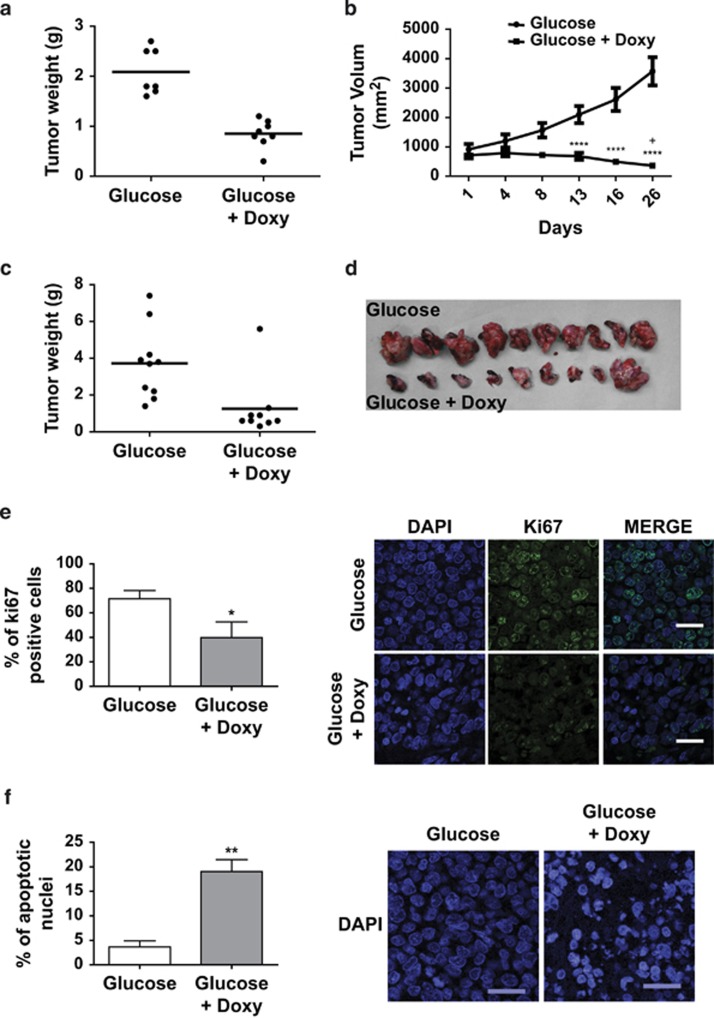
HDAC7 impairs the oncogenic capacity of SD-1 and Namalwa cells. Xenographic assays were performed with SD-1-Tet-On-Tight-HDAC7 and Namalwa-Tet-On-Tight-HDAC7 cells. SD-1 cells (5 × 106) were injected subcutaneously and 1.5 × 106 Namalwa cells were orthotopically injected into the spleen. Treatment with doxycycline was started 2 weeks after injection. (a) and (b) Tumor weight at the end point of the experiment and tumor growth during the experiment of SD-1-Tet-On-Tight HDAC7 cell xenographic assays. (c) and (d) Graph of tumor weight and pictures of the tumors of Namalwa Tet-On-Tight-HDAC7 cell xenographic assays. (e) HDAC7 expression reduced the number of KI67-positive cells and promoted an increased in the number of apoptotic nuclei. Panel (e) shows the frequency of Ki67-positive cells in the SD-1-Tet-On-Tight-HDAC7 xenographic assay. More than 2400 cells per animal (three glucose; three glucose+Doxy) were analyzed. *P<0.05. (f) Percentage of condensed or fragmented nuclei of all nuclei from >2400 cells per animal (three glucose; three glucose+Doxy). **P<0.01